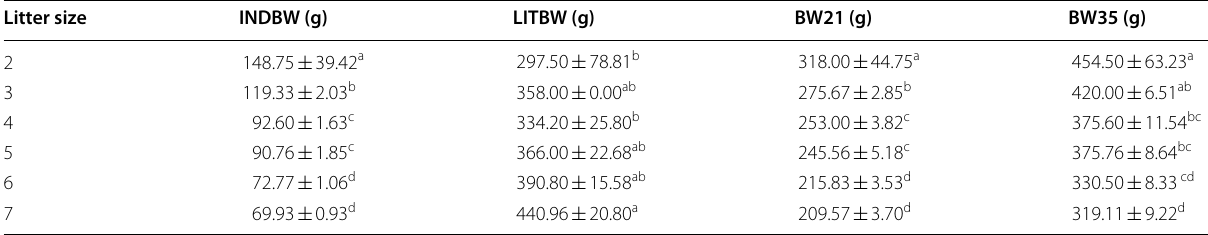
Table 4 Effect of litter size on body weight of crossbred kits